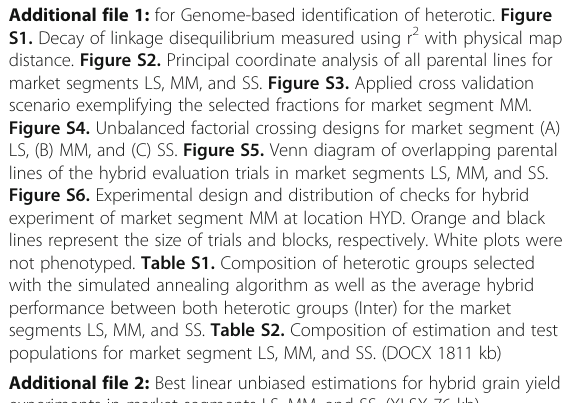
lines represent the size of trials and blocks, respectively. White plots were not phenotyped. Table S1. Composition of heterotic groups selected